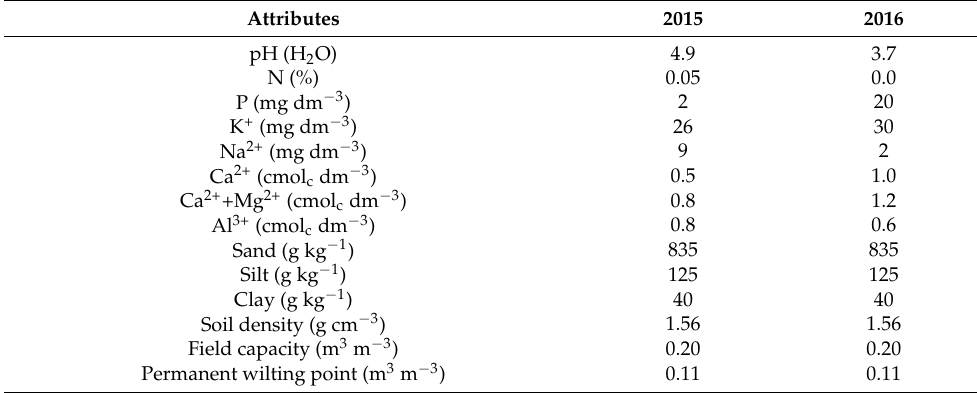
Table 1. Physical and chemical attributes of the soil from the experimental